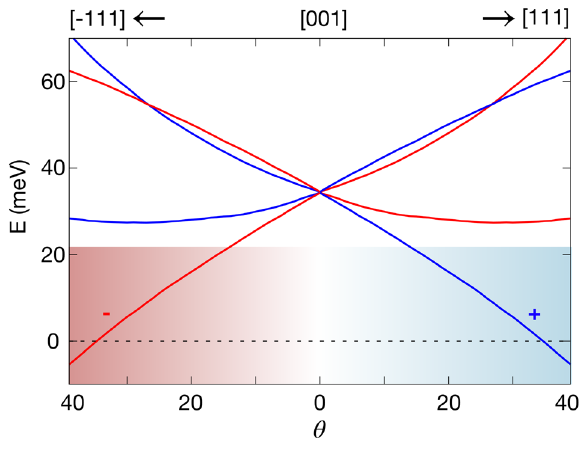
Fig. 4 Chirality imbalance in GdCoC 2 . Energy of the Weyl nodes as a function of the canting angle θ for GdCoC 2 . Blue and red lines, respectively, correspond to Weyl nodes of positive and negative